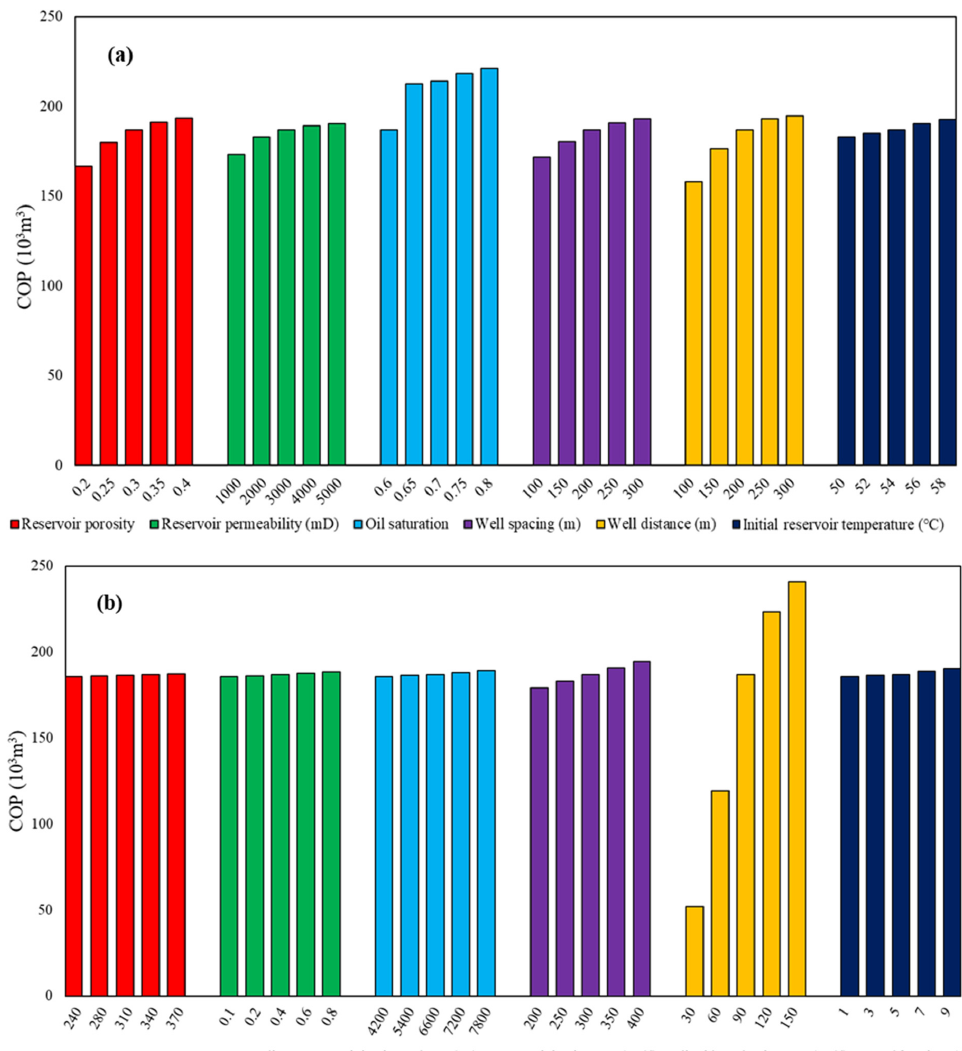
Figure 4. The calculated COP of the horizontal CSS well at various conditions: ( a ) well and geological conditions; ( b ) operational conditions.